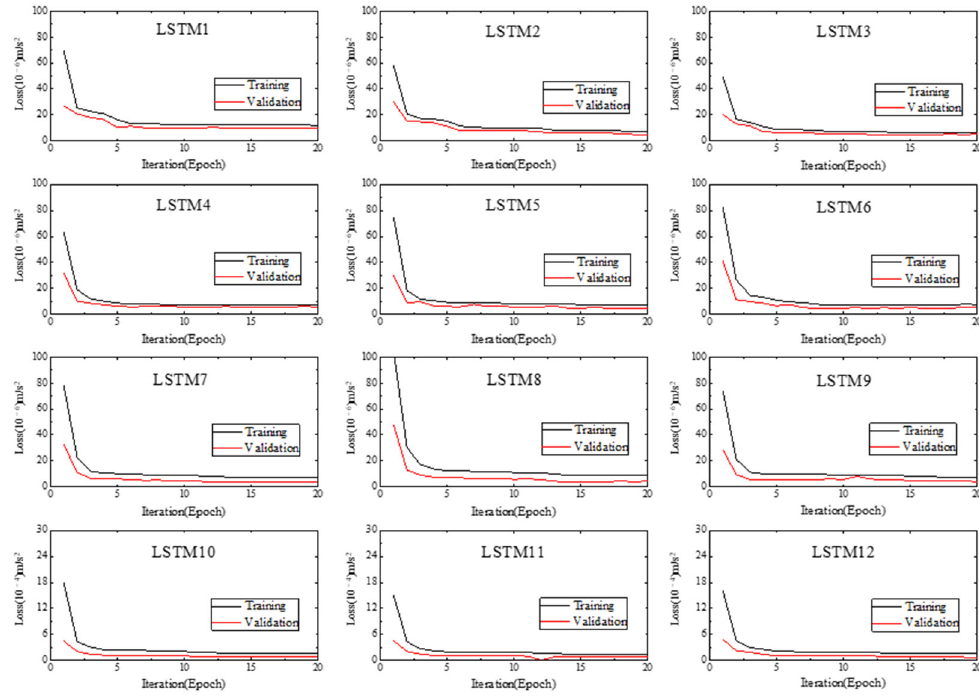
Figure 12. The training and validation processes.